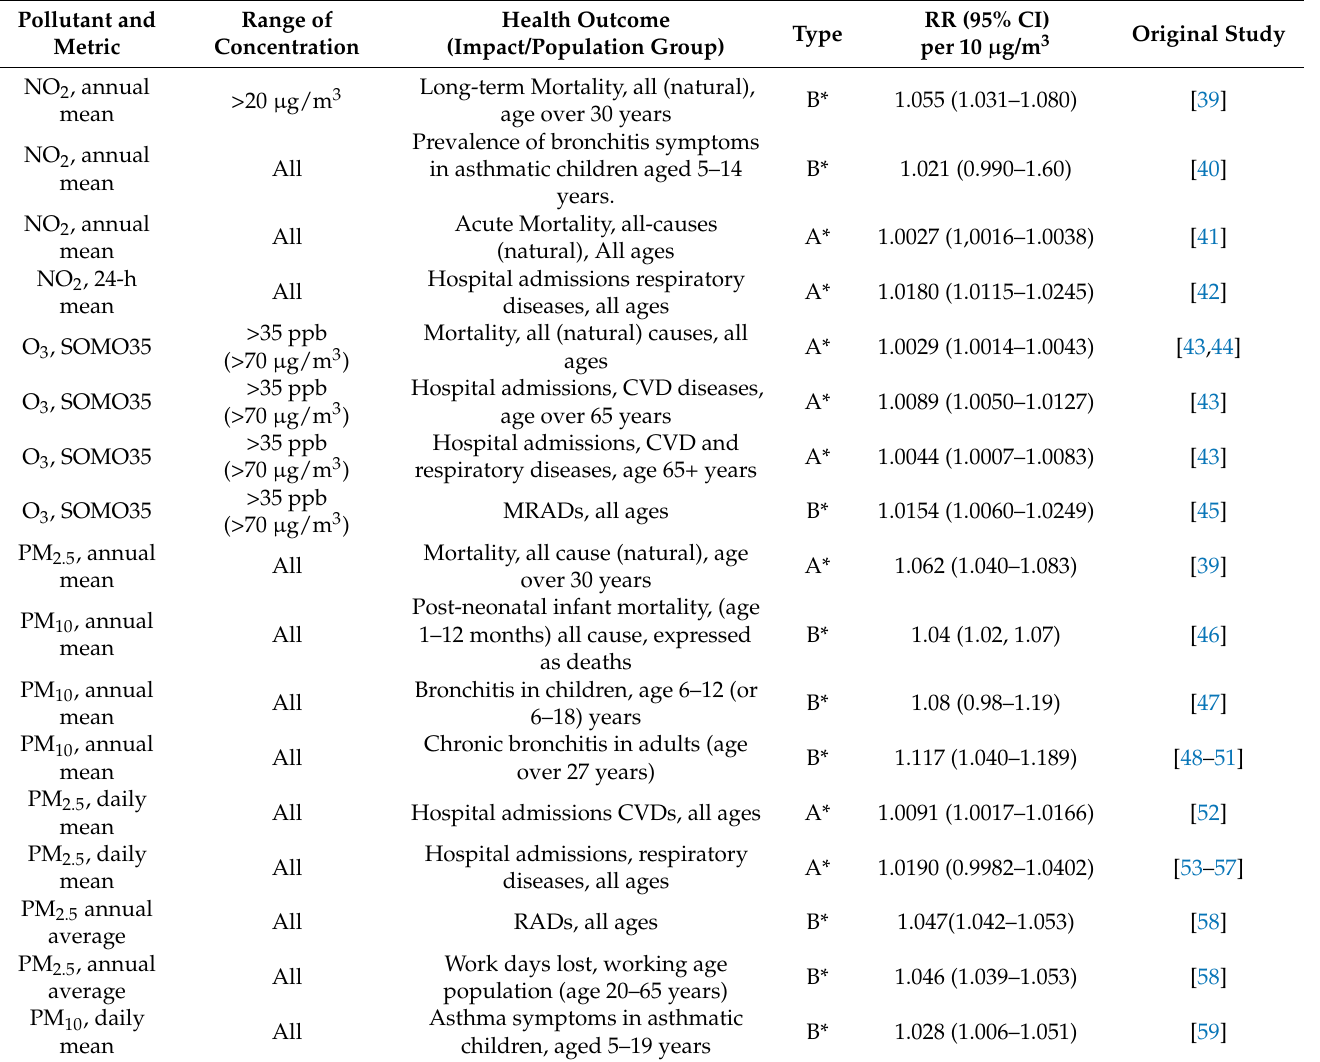
Table 1. Recommended concentration–response functions (CRFs) used in the study [27]. RAD: Restricted activity days, MRAD: minor restricted activity